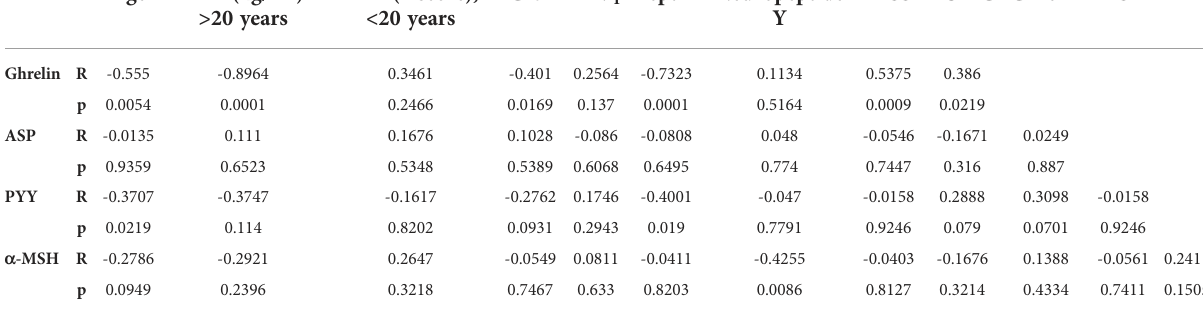
TABLE 4 Spearman ’ s rank correlation coef fi cients and p